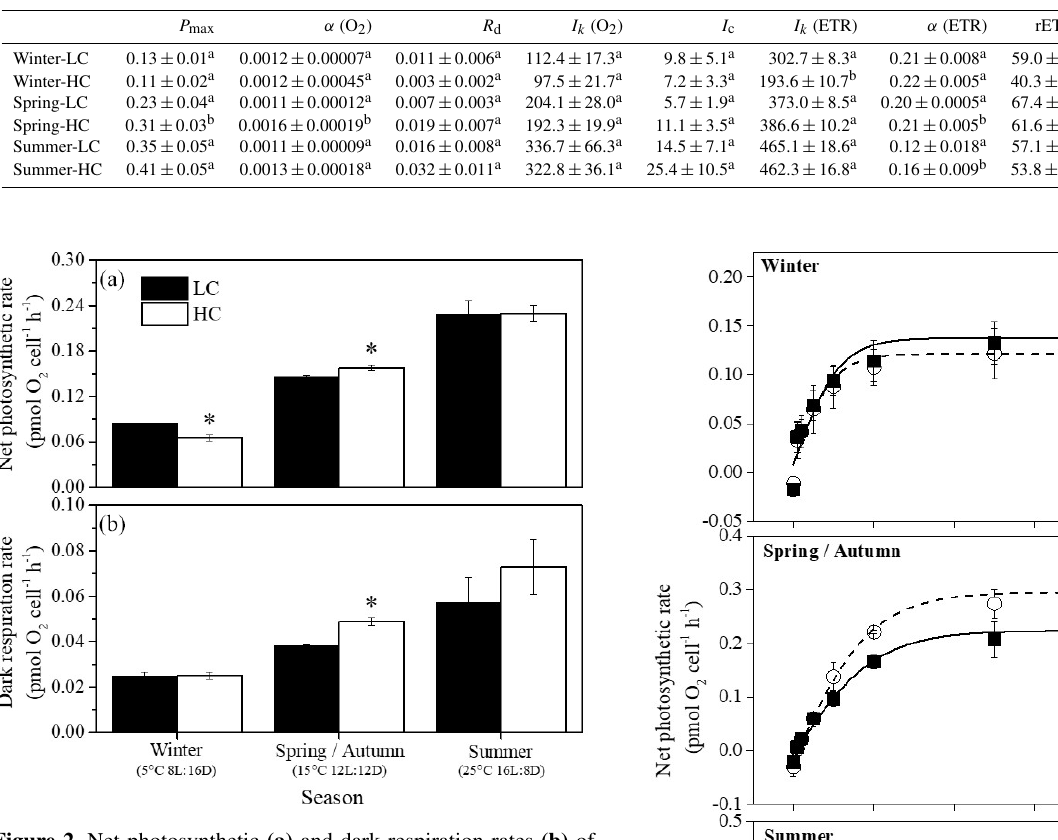
Figure 2. Net photosynthetic (a) and dark respiration rates (b) of S. costatum acclimated to ambient (LC, black bars) and elevated p CO 2 (HC, white bars) under different combinations of tempera- ture and photoperiod conditions. The data are mean ± SD values of triplicate cultures ( n = 3). Asterisks represent significant differ- ences ( P < 0 . 05) between two CO 2 levels under the same season conditions ( t test).